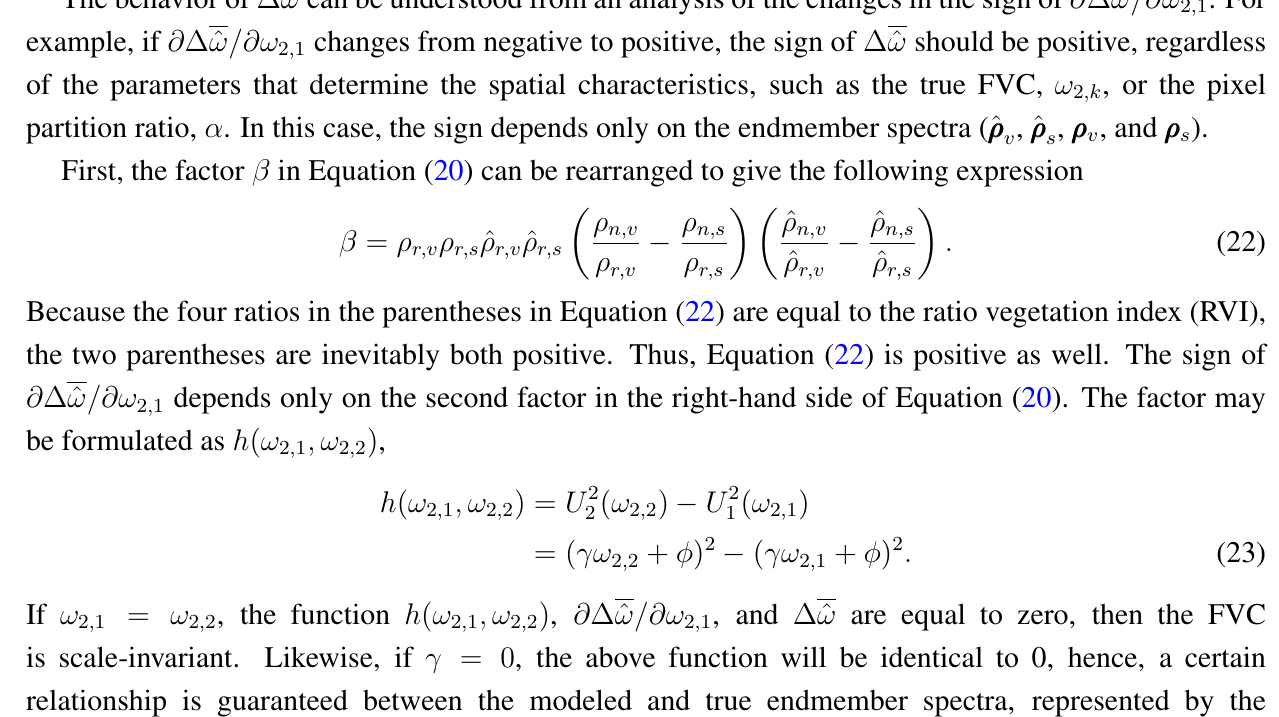
Figure 5. Empty and filled squares represent the true vegetation and non-vegetation endmember spectra, respectively. Similarly, the circular symbols indicate the vegetation and non-vegetation endmember spectra, respectively, assumed in the